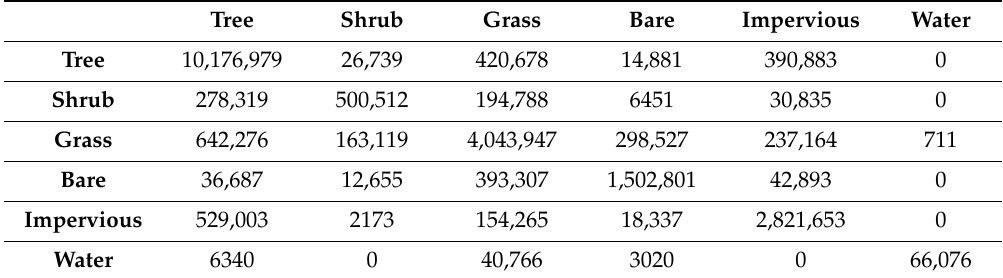
Table 13. Confusion matrix with uniform weights (Oregon—6 classes). Tree